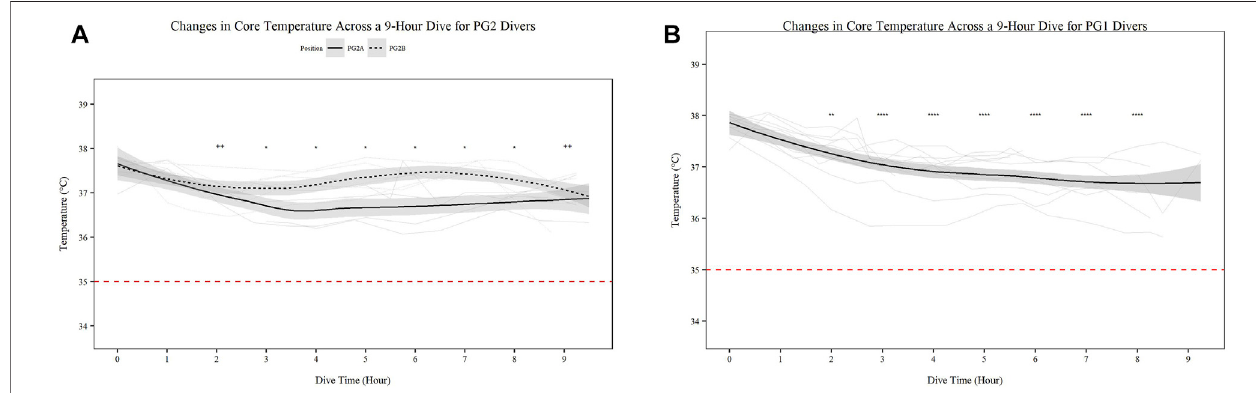
FIGURE1| ChangesinCoreTemperatureacrossa9-hDiveforPG2Aand PG2B (A) andPG1 (B) divers.Changesincoretemperature foreach diveracrosseach divearerepresented.Eachdiverisassociatedwithacolorfoundinthelegend.PG2Baredepictedassolidlines;andPG2Aaredepictedasdashedlines.Thereddashed linerepresentsthe35 ° C,thepointofhypothermiaonset.* p < 0.05,** p < 0.01,*** p < 0.001,**** p < 0.0001;*=PG2A,+=PG2B.AllcomparisonsareinrelationtoHour0. Trend line created using loess function with standard error band. Red dashed line represents cutoff for hypothermia.